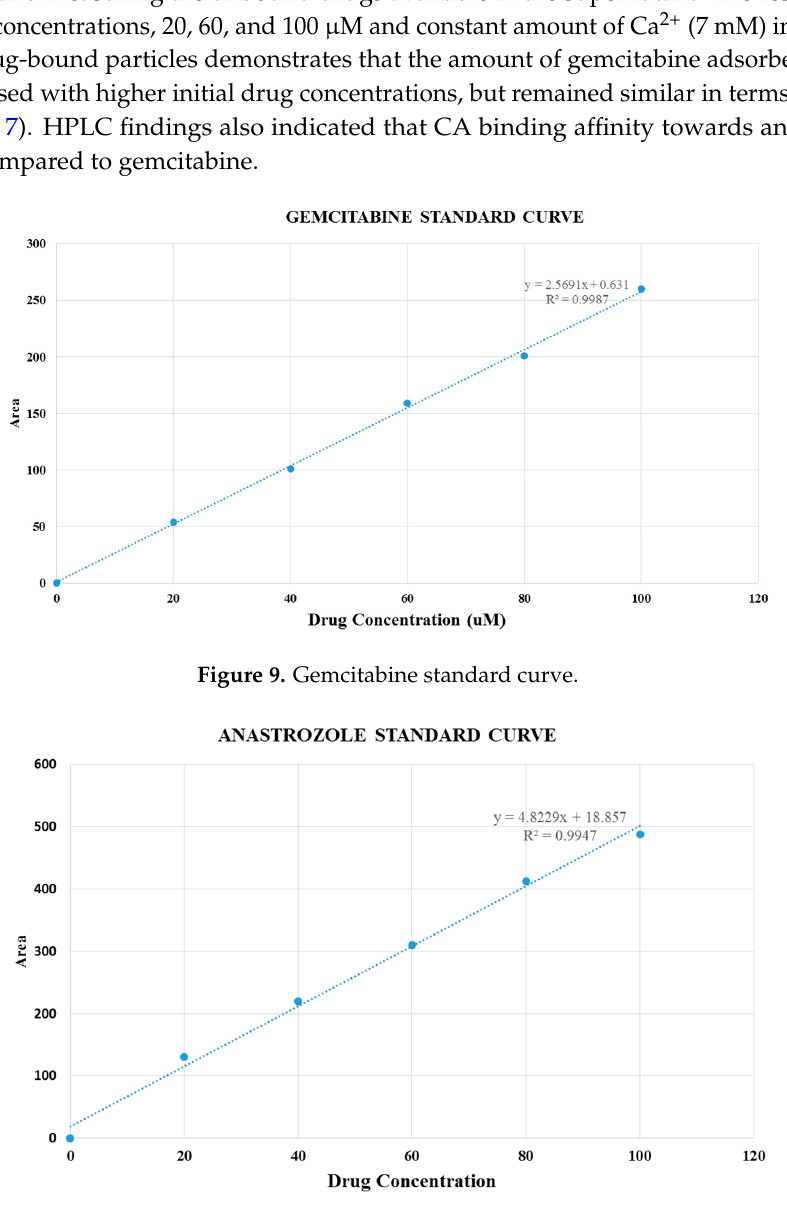
Figure 10. Standard curve of anastrozole. Table 7. Estimation of gemcitabine and anastrozole binding affinity to CA particles in three different drug concentrations (20, 60 and 100 μ M).